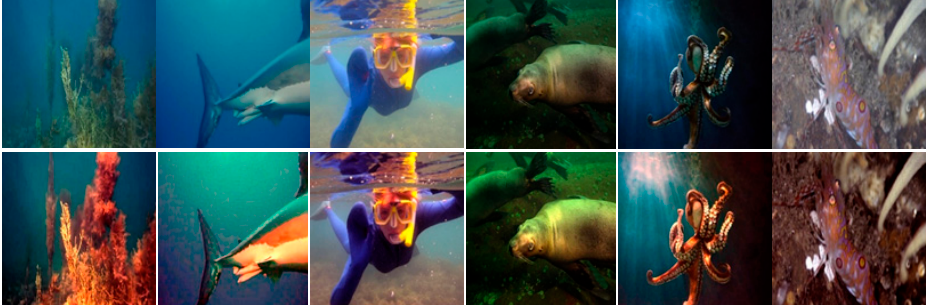
Figure 3. UCM experimental results.